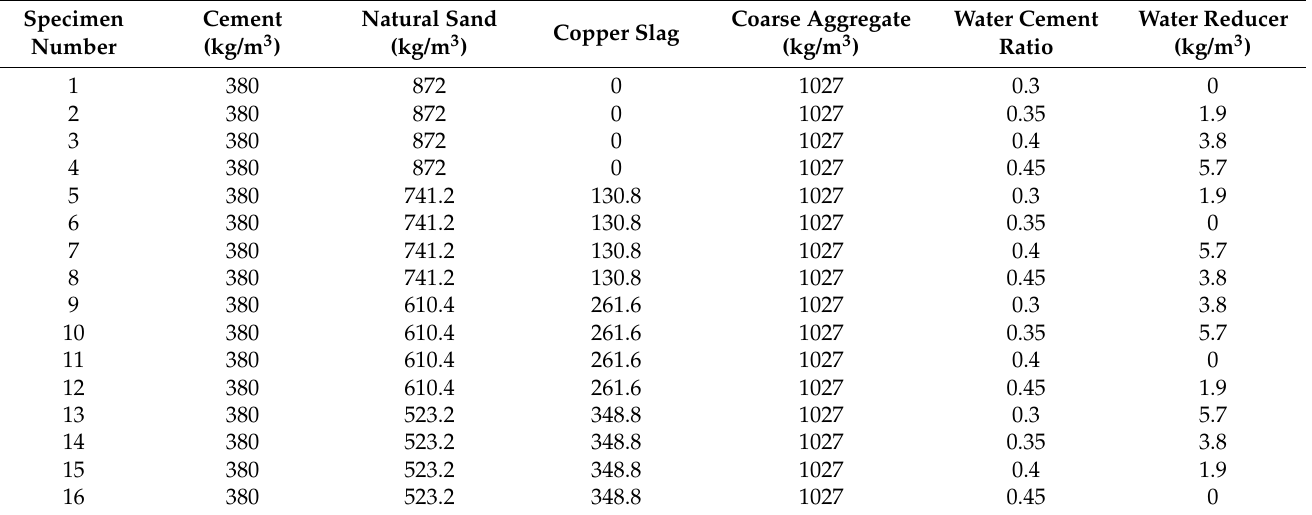
Table 7. Experimental design table.